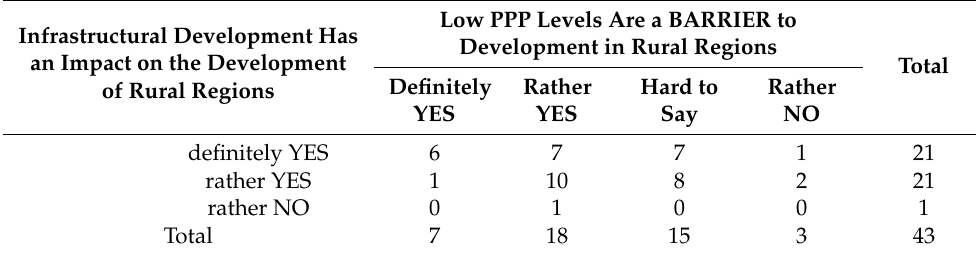
Table 1. Opinion of those recognizing the impact of infrastructure development on rural development on recognizing the low level of public–private partnerships as a barrier to that development.